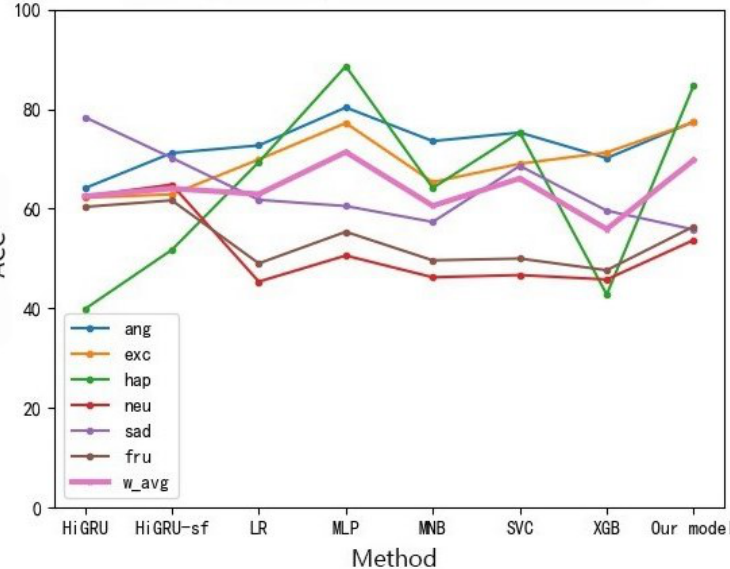
Figure 11. Fine-grained Emotion Accuracy Rate Analysis of Different IEMOCAP Methods